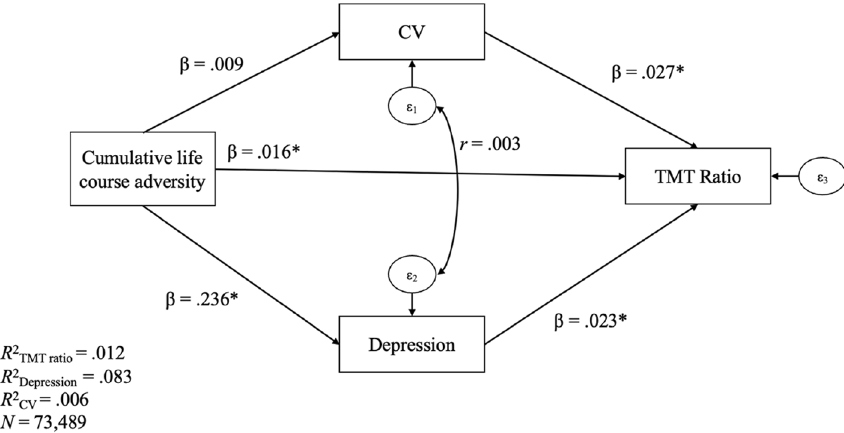
Figure 1. Standardized coefficients for the path analysis and explained variance for each endogenous variable of the model. * p < .001, CV = Coefficient of variation, TMT The Trail Making Test. Note. For clarity, pathways with the covariates are not reported.